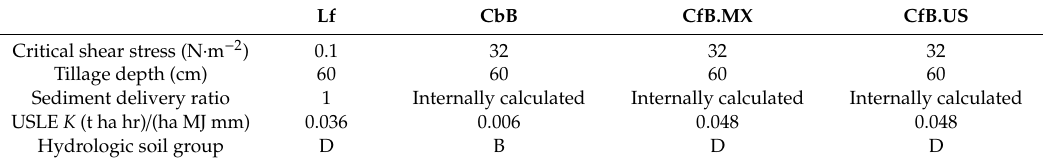
Table 3. AnnAGNPS soil erosion parameters used to calibrate the watershed scale model for sediments. Lf CbB CfB.MX